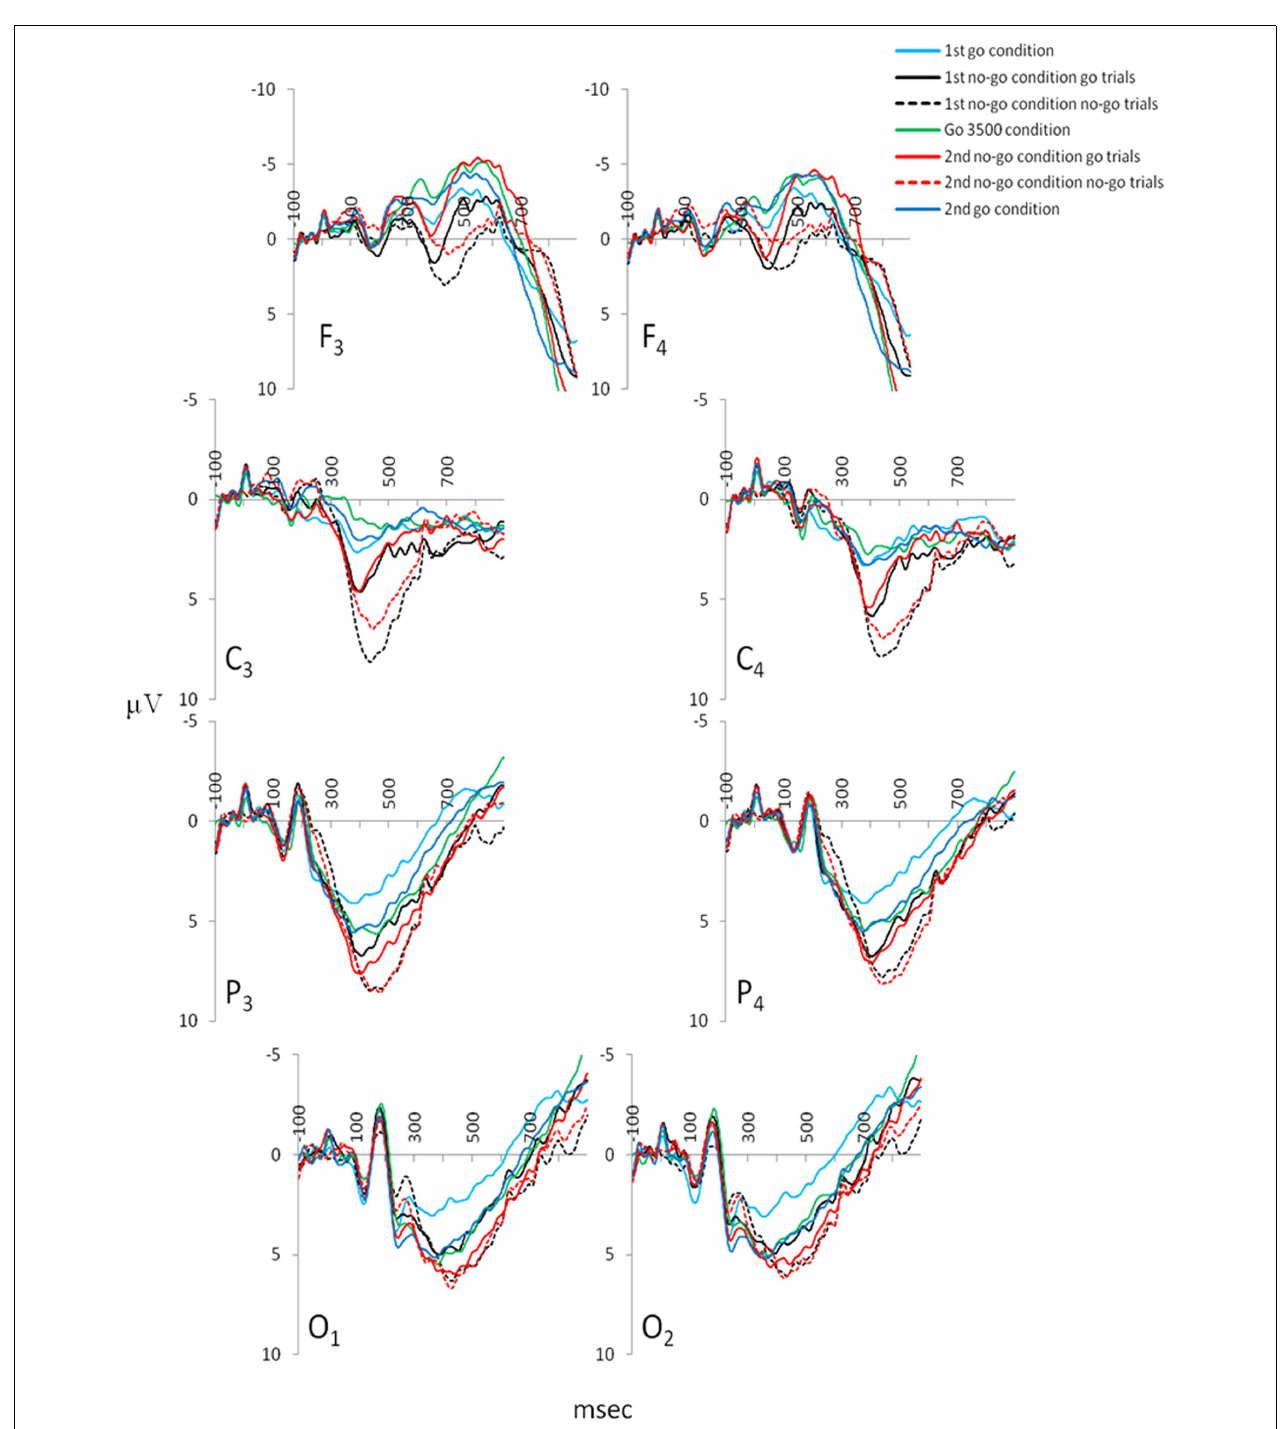
FIGURE 5 | Grand mean ERPs extracted for the various conditions of the GNG: frontal electrodes (F 3 and F 4 ), central electrodes (C3 and C4), parietal electrodes (P 3 and P 4 ) from which the P300 amplitudes and latencies were extracted, and occipital electrodes (O1 and O2; n grandmeanaverage = 53).